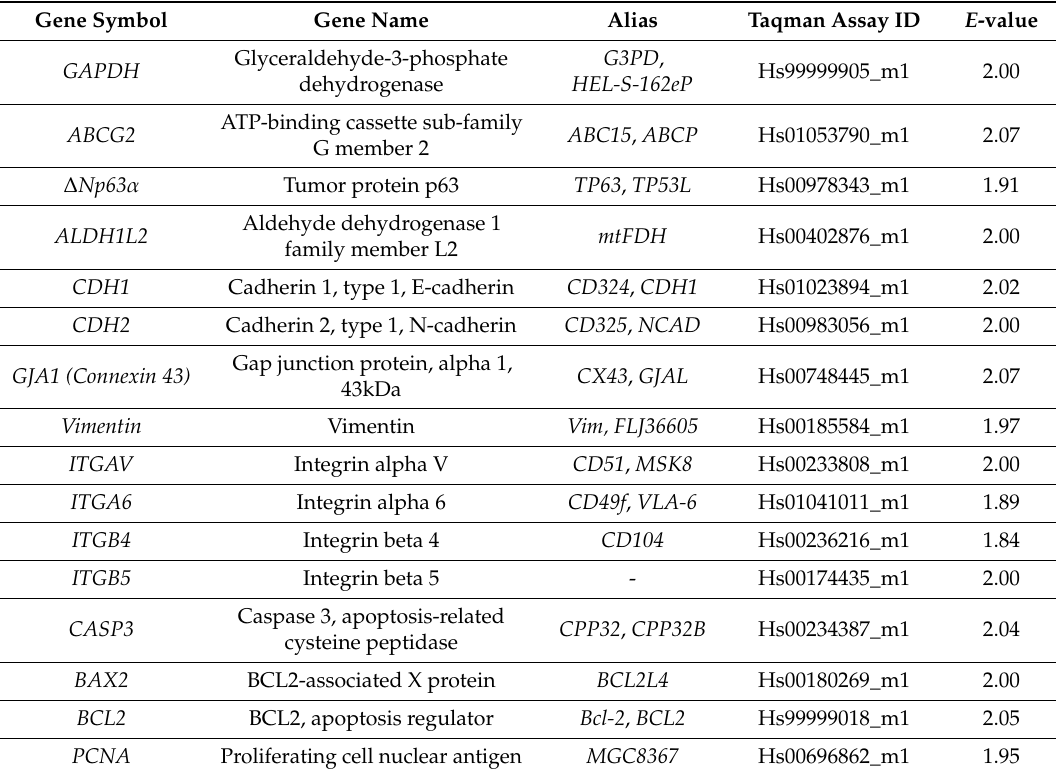
Table 3. List of primers used in gene expression